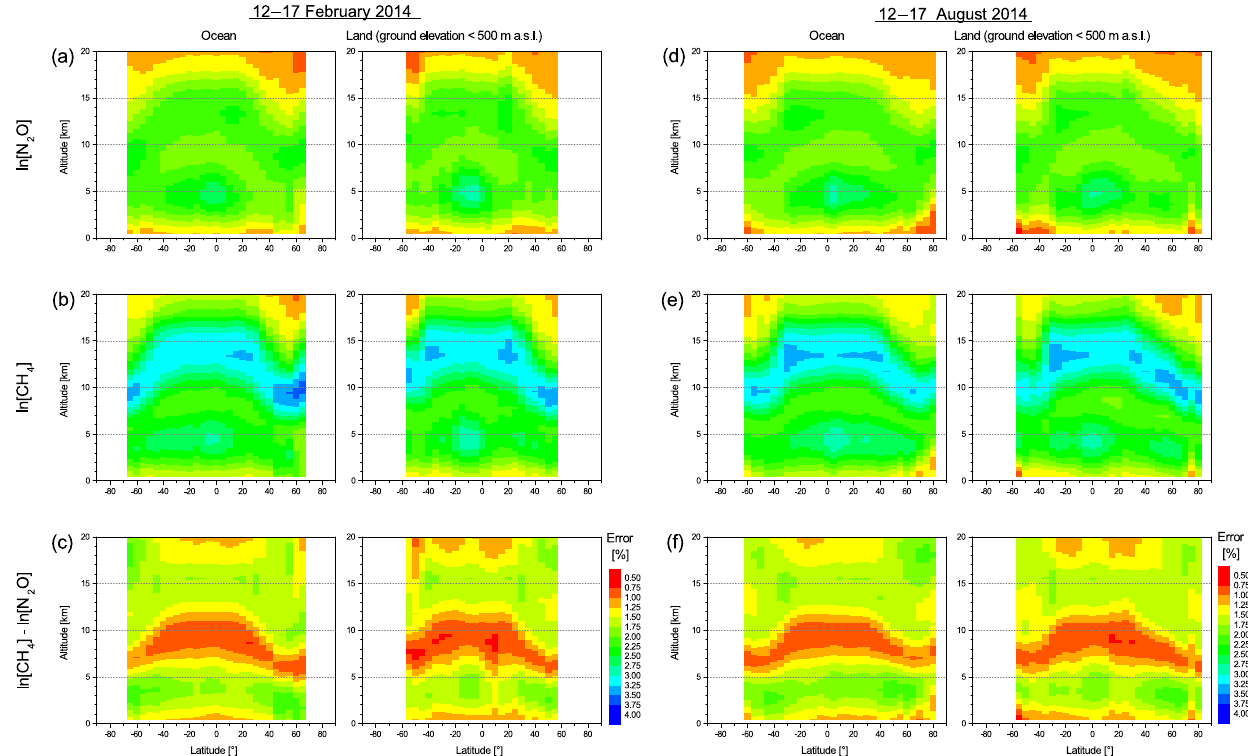
Figure 6. Latitudinal cuts as in Fig. 4, but for the leading statistical errors (atmospheric temperature and measurement noise).